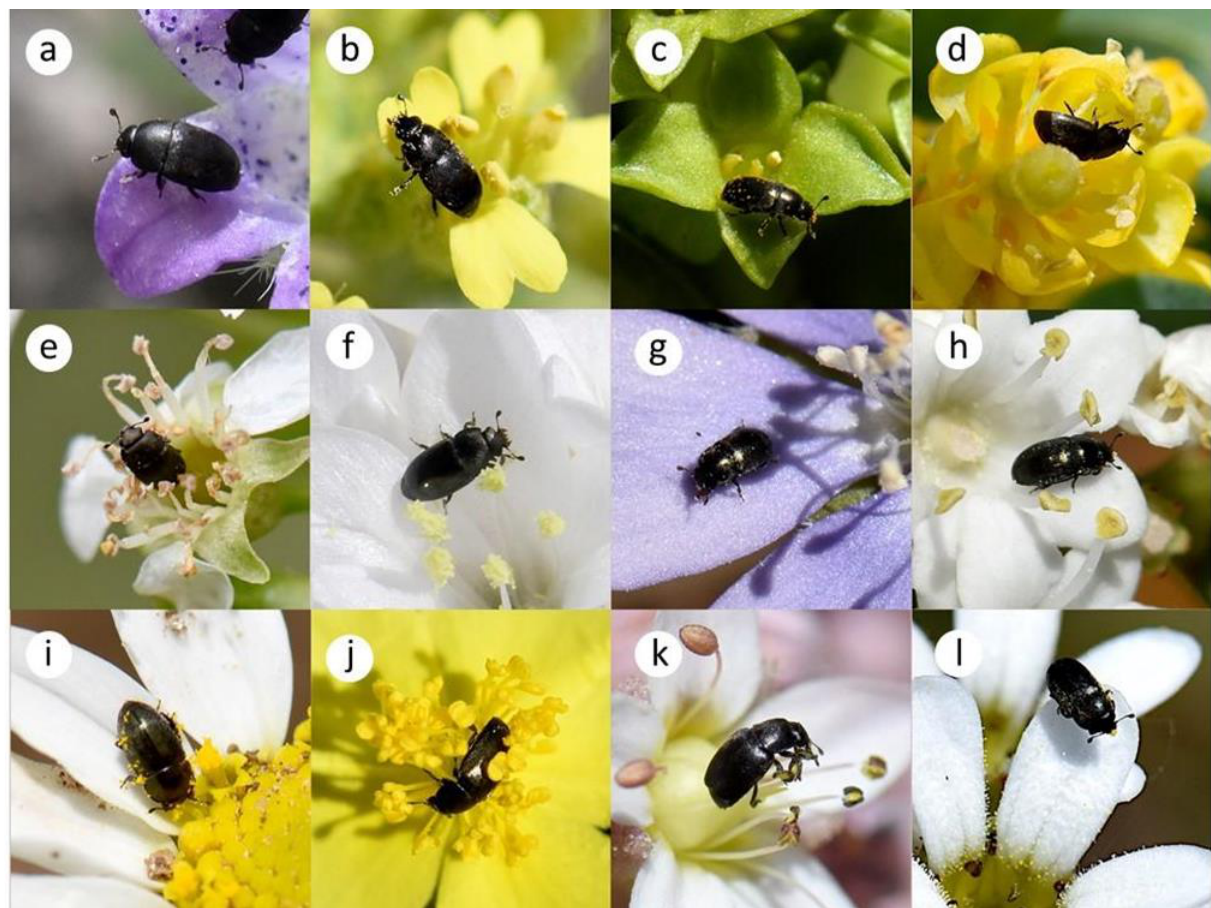
Figure 1. Nitidulid beetles in flowers, exemplifying the broad variety of flowers where they were recorded. Each picture corresponds to a different plant family: a, Campanula mollis (Campanulaceae); b, Draba hispanica (Brassicaceae); c, Daphne laureola (Thymelaeaceae); d, Berberis hispanica (Berberidaceae); e, Prunus mahaleb (Rosaceae); f, Armeria filicaulis (Plumbaginaceae); g, Hepatica nobilis (Ranunculaceae); h, Viburnum tinus (Adoxaceae); i, Anthemis pedunculata (Asteraceae); j, Helianthemum oelandicum (Cistaceae); k, Sedum dasyphyllum (Crassulaceae); l, Saxifraga carpetana (Saxifragaceae). Although species of Nitidulidae cannot be safely identified from photographs, most individuals depicted probably are Brassicogethes aeneus